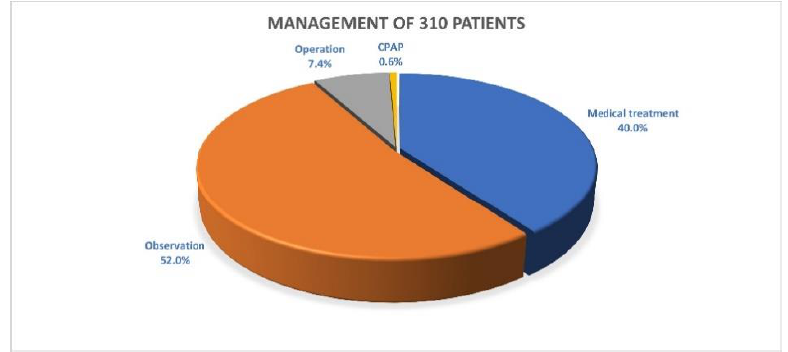
Figure 1. Management of 310 patients. CPAP: Continuous positive airway pressure.